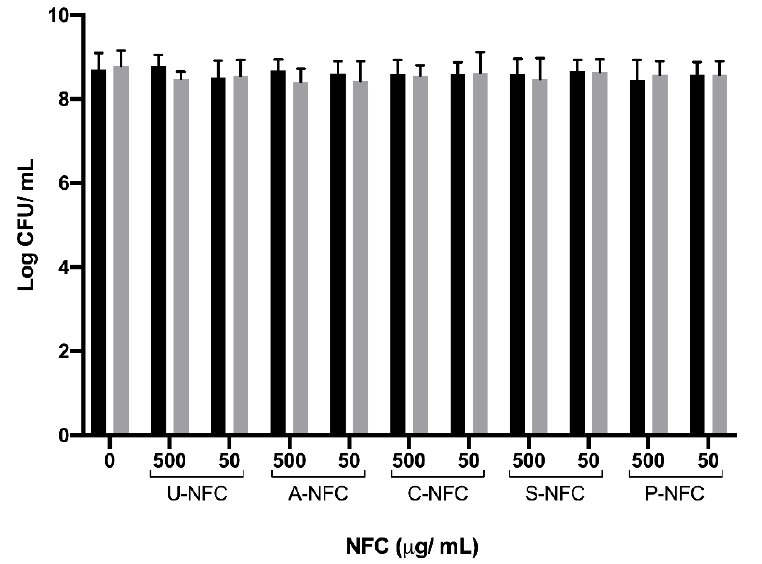
Figure 6. Counts (mean log CFU / mL) for E. coli and L. reuteri bacteria after exposure to the NFC materials. Data are presented as mean ± SEM of three independent experiments No statistically significant differences were found between NFC-treated and non-treated bacteria.